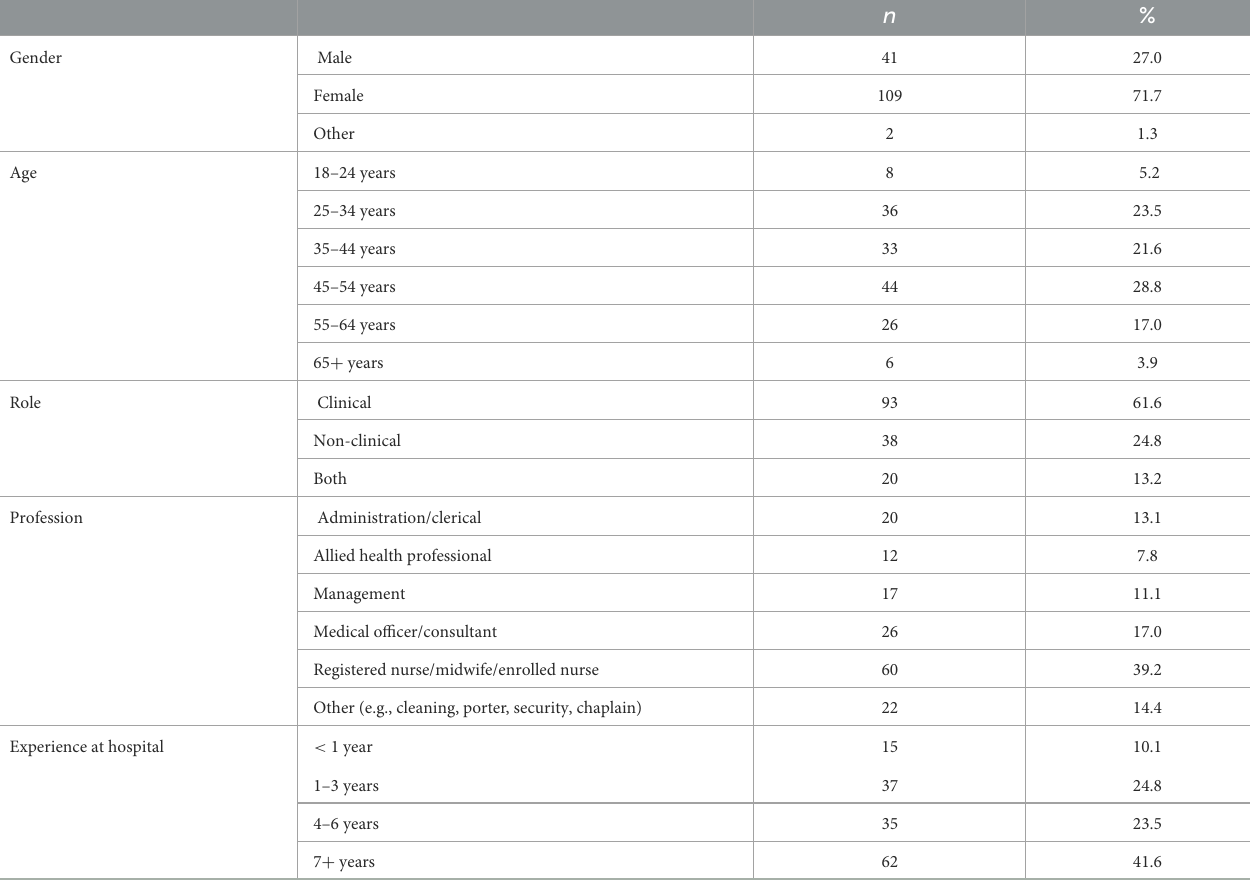
TABLE 1 Demographic and work characteristics of respondents ( N = 153).